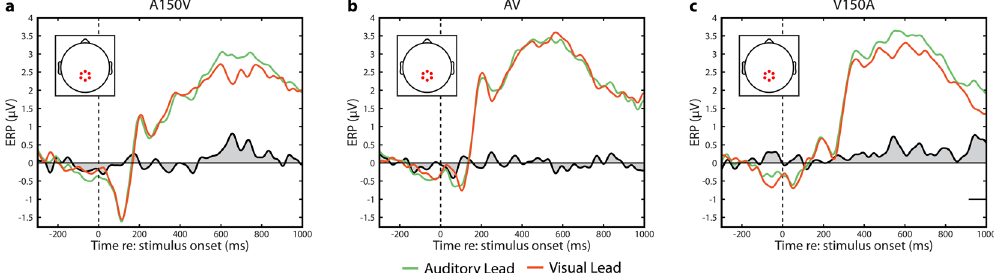
Figure 6. ERPs for small SOAs (A150V, AV, and V150A). Data were averaged across the six electrodes indicated. ( a ) ERPs in the A150V condition binned depending on whether the previous trial was an auditory lead (green) or a visual lead (orange). No significant differences are present. ( b ) ERPs in the AV condition binned depending on whether the previous trial was an auditory lead (green) or a visual lead (orange). No significant differences are present. ( c ) ERPs in the V150 condition binned depending on whether the previous trial was an auditory lead (green) or a visual lead (orange). Significant differences are present from 914–1000 ms (p = 0.013, randomization test), and are indicated by the black underline. A marginally significant effect is present from 517–573 ms (p = 0.0443, randomization test).